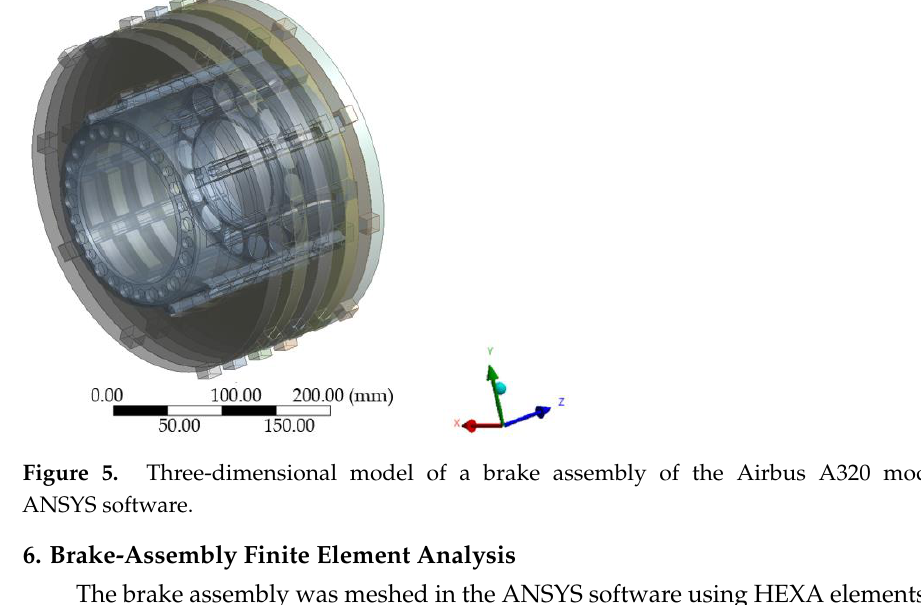
Figure 6. Finite element model and application of the boundary condition .